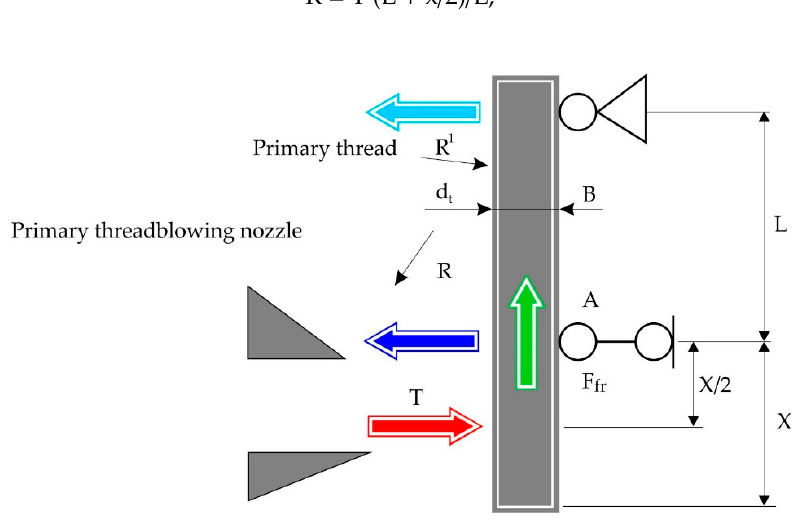
Figure 8. Conclusion of the stability condition of the primary thread.